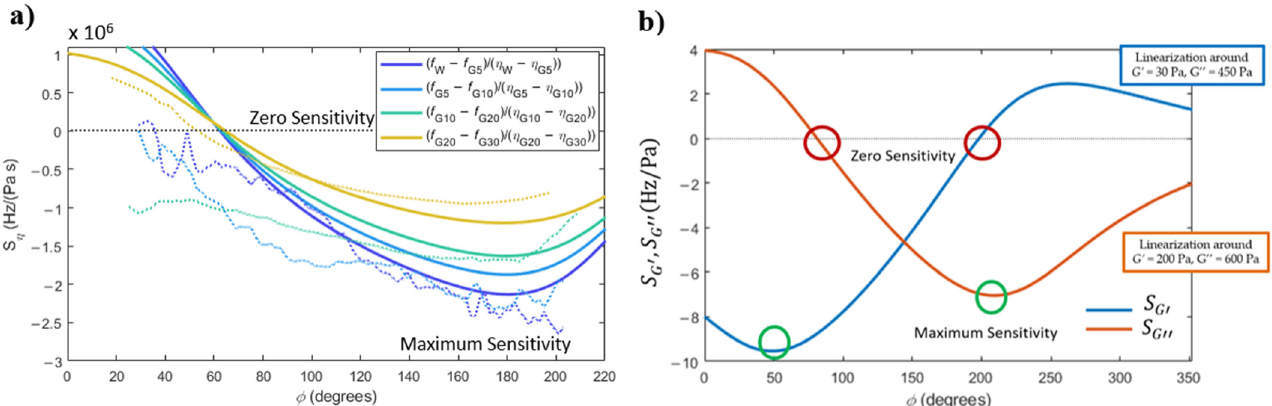
Figure 5. ( a ) Sensitivity to variations in viscosity in a Newtonian fluid (solid and dashed lines represent experimental and modelled results, respectively); ( b ) modelled sensitivity to variations in the elastic and viscous modulus in a non-Newtonian viscoelastic fluid.